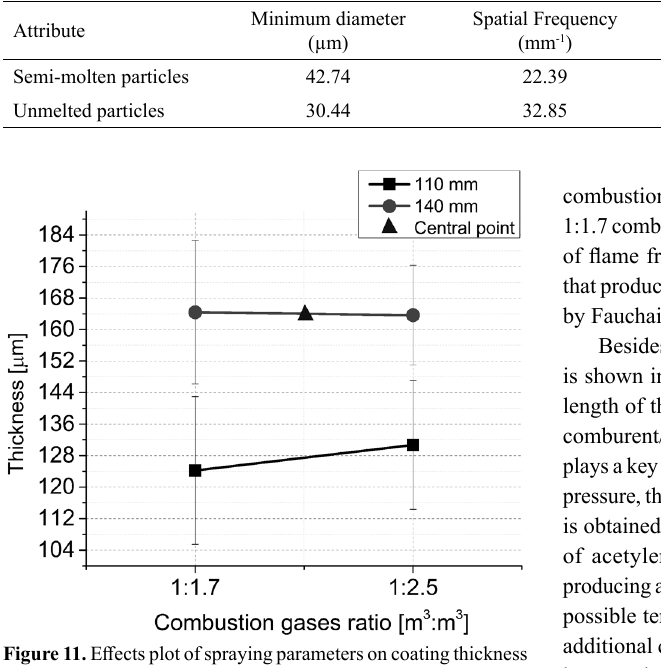
Table 5. Attributes of interest after PSD analysis.